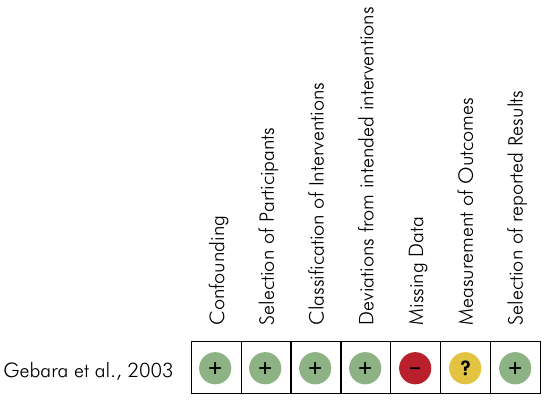
Figure 6. Summary Risk of bias of non-randomized clinical